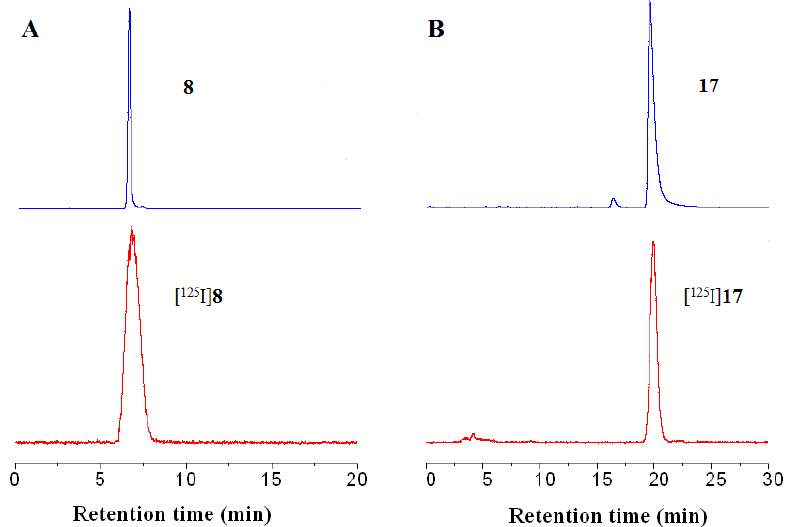
Figure 3. HPLC profiles of 8 (A, top), [ 125 I] 8 (A, bottom) and 17 (B, top), [ 125 I] 17 (B,